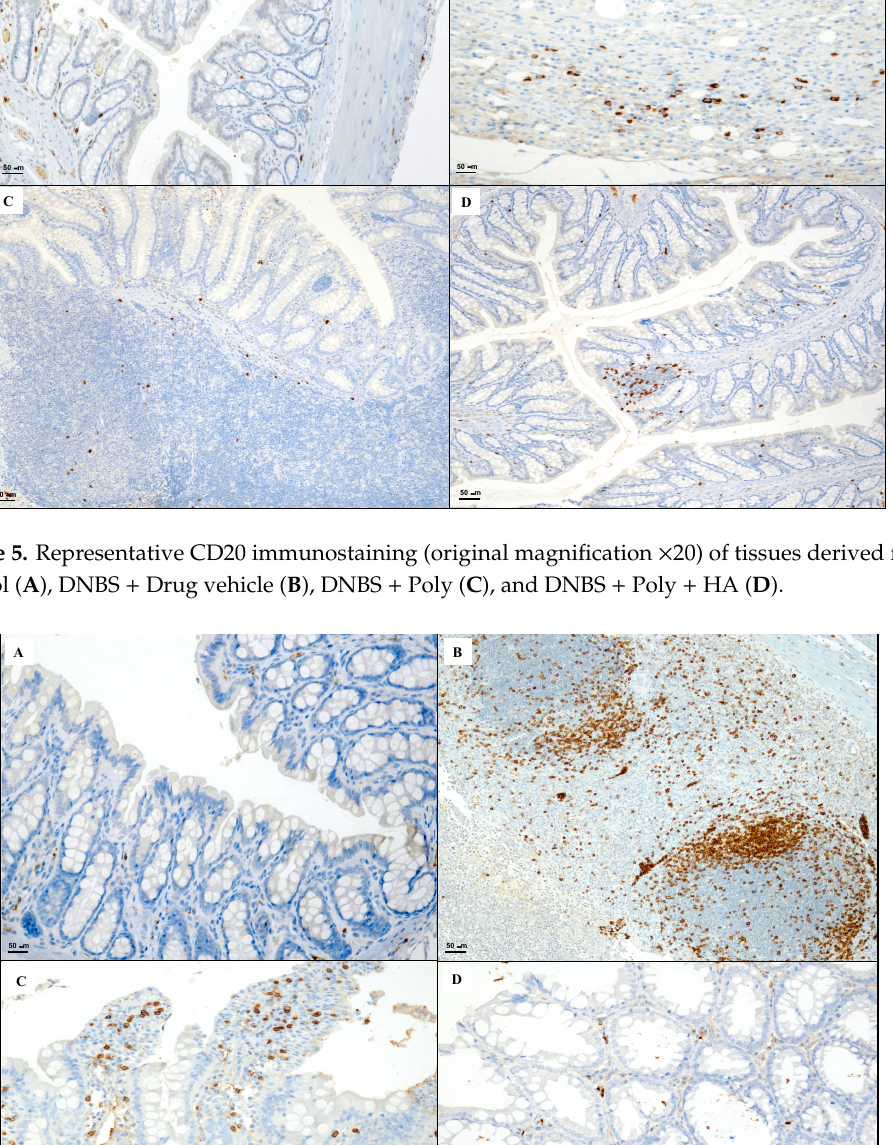
Figure 6. Representative CD44 immunostaining (original magnification ×20) of tissues derived from control ( A ), DNBS + Drug vehicle ( B ), DNBS + Poly ( C ), and DNBS + Poly + HA ( D ).